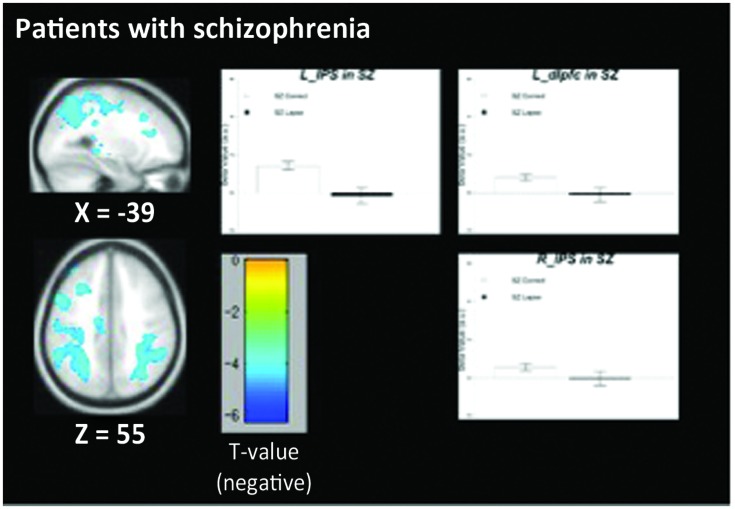
Regions showing decreased BOLD signal during lapse trials compared to correct trials in patients with schizophrenia. Beta values for right intraparietal sulcus (IPS), left IPS, and left dorsolateral prefrontal cortex (dlPFC) are shown. Error bars are ±SEM. Scale bar shows t-value for each voxel. Cluster-level FWE corrected at p < 0.05, voxel-wise threshold p < 0.01.